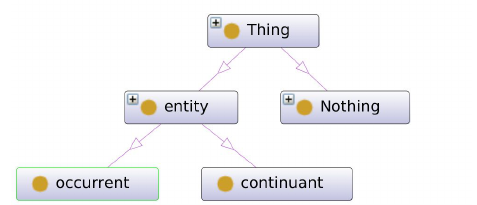
Figure 1. Top-level distinction between continuants and occurents Endurants include physical objects, for example: building, road,